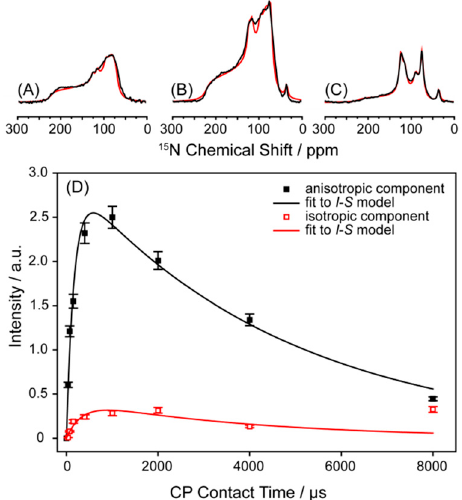
Figure 1. Proton-decoupled static 15 N NMR spectra of uniformly 15 N-labeled neuropeptide Y receptor type 1 (Y1R) in DMPC membranes at cross-polarization (CP) contact times of 70 μ s ( A ), 1000 μ s ( B ), and 8000 μ s ( C ) acquired at a temperature of 30 °C (NMR spectra are plotted to scale). Experimental NMR spectra are shown in black and simulations of the spectral line shape in red. The areas of the deconvoluted isotropic and anisotropic backbone signals are plotted as a function of the CP contact time in ( D ). These intensities were fitted to the I–S model illustrated as solid lines [48].